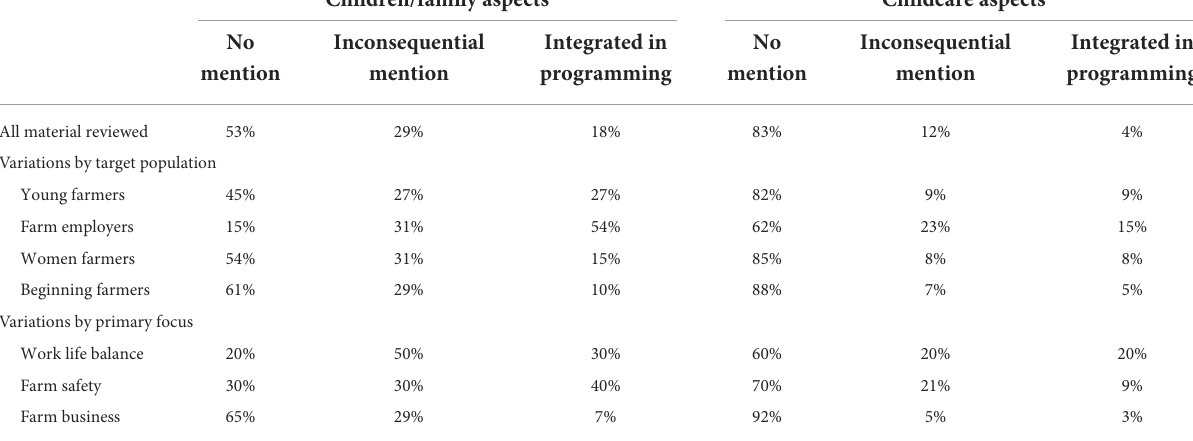
TABLE 2 Coverage of children/family and childcare aspects in farm programming ( n =